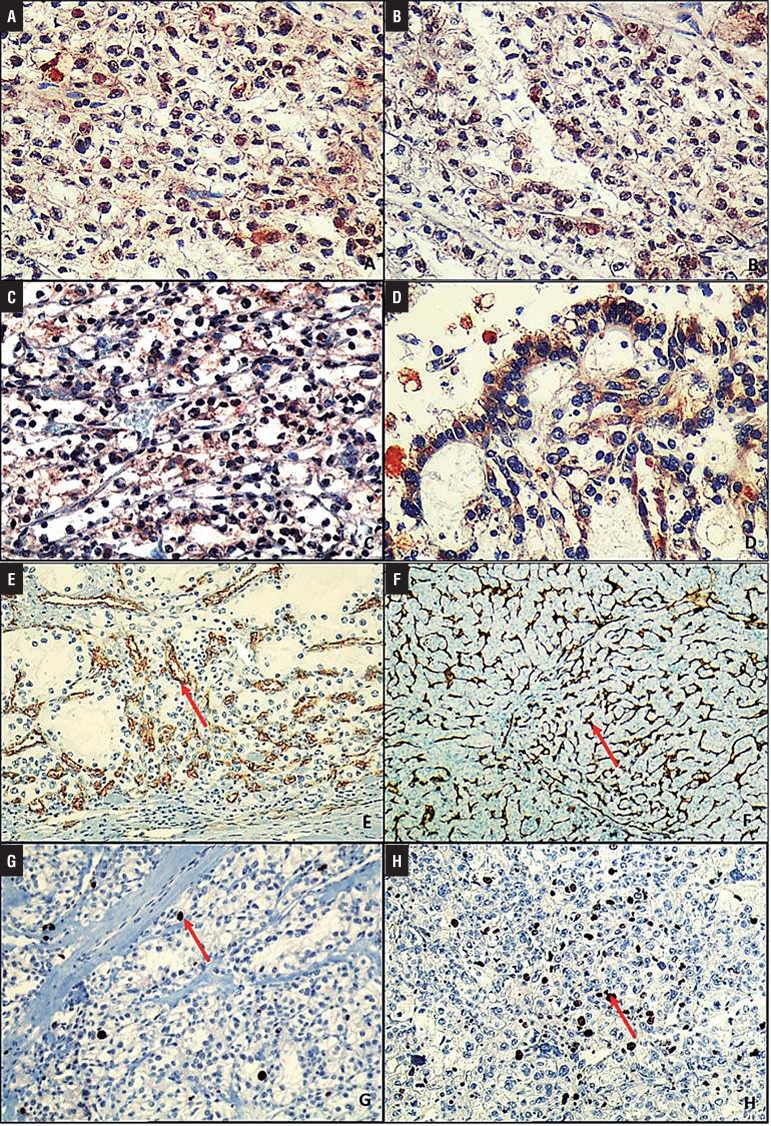
Immunohistochemical staining examples of ccRCCs. A) Widespread, strongly HIF 1α positivity (X400), B) Widespread, moderate HIF 2α positivity (X400), C) Widespread, moderate (X200) and D) focally, strong VEGF positivity (X400), E) Numerous CD34 positive moderate sized and F) small sized vessels (arrow) (X100), G) Nuclear Ki-67 positivity (X200), H) Nuclear p53 positivity (X200) (arrow in G and H: nuclear staining).